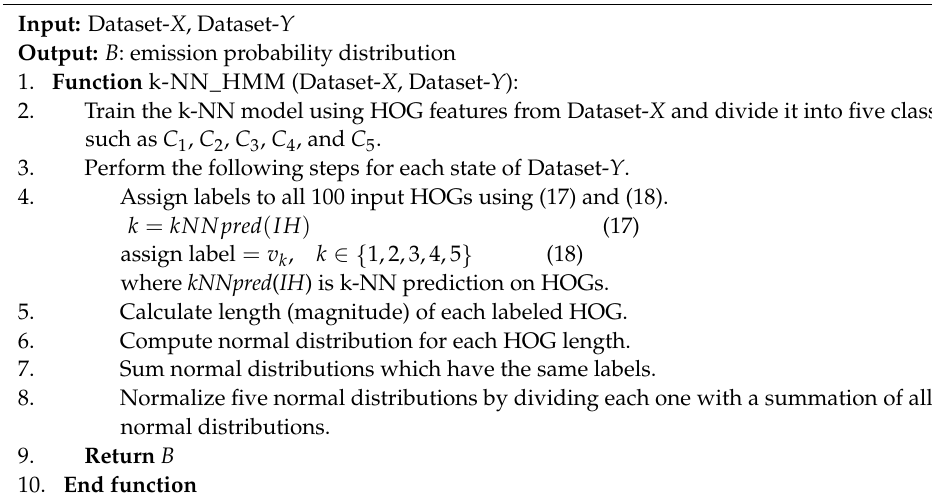
Algorithm 2. Calculation of B by Computing k-NN